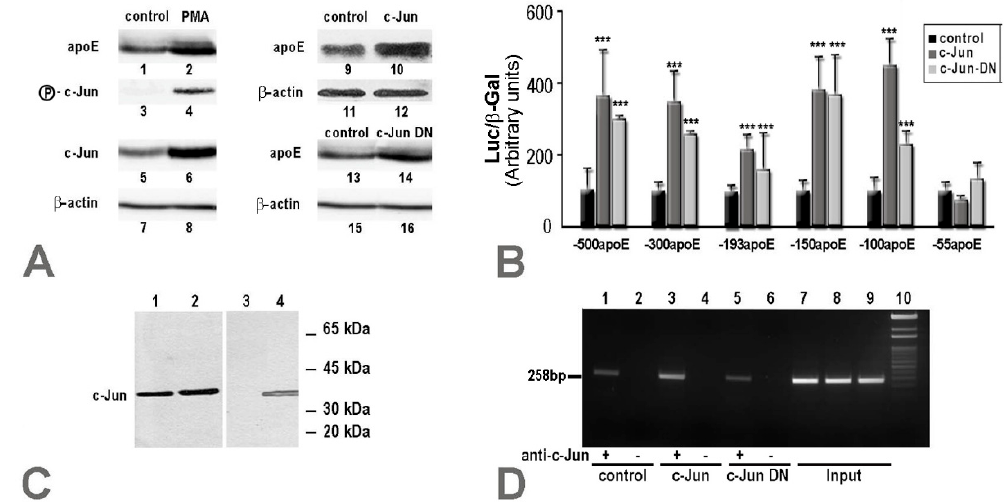
Figure 3. In hepatocytes, c-Jun transcription factors bound to the apoE promoter and upregulated its activity. ( A ) PMA stimulation of HepG2 cells induced phospho-c-Jun expression (lane 4 vs. 3) and increased total c-Jun protein levels (lane 6 vs. 5), which led to an increased apoE protein expression (lane 2 vs. 1), as demonstrated by Western blot. An increase in apoE protein level was noticed also when the cells were transfected to overexpress c-Jun (lane 10 vs. 9). A similar increase in apoE protein level (lane 14 vs. 13) was induced by overexpression of the dominant negative form of c-Jun (c-Jun DN). The expression of β -actin was used as an internal control (lanes 7, 8, 11, 12, 15, and 16); ( B ) From a series of apoE promoter deletion mutants used for HepG2 cell transfection, only the fragment − 55apoE was not affected by c-Jun or c-Jun DN overexpression, and the smallest apoE fragment activated was -100apoE; ( C ) DNAP assays using nuclear extracts from HepG2 cells showed that c-Jun proteins bound to − 300apoE and − 100apoE (lanes 1 and 2, respectively). The positive control represents the c-Jun level in the nuclear extract from HepG2 cells (lane 4). In the negative control, a nonspecific biotinylated DNA fragment was used in the DNAP assays (lane 3); ( D ) Chromatin immunoprecipitation (ChIP) assay using chromatin from HepG2 hepatocytes (control cells or cells overexpressing c-Jun or c-Jun DN) and anti-c-Jun antibodies showed that c-Jun bound to the apoE promoter. Higher amounts of apoE promoter DNA were immunoprecipitated from HepG2 cells overexpressing c-Jun (lane 3) compared to control cells (lane 1) or hepatocytes transfected with c-Jun DN (lane 5). In the negative controls, nonspecific IgG was used to precipitate chromatin from control cells (lane 2), HepG2 cells transfected with c-Jun (lane 4) or c-Jun DN (lane 6), and no PCR products were identified. The input, representing 1% from each type of chromatin sample obtained from the control or c-Jun/c-Jun DN transfected hepatocytes, produced the expected band (lanes 7, 8, and 9, respectively).